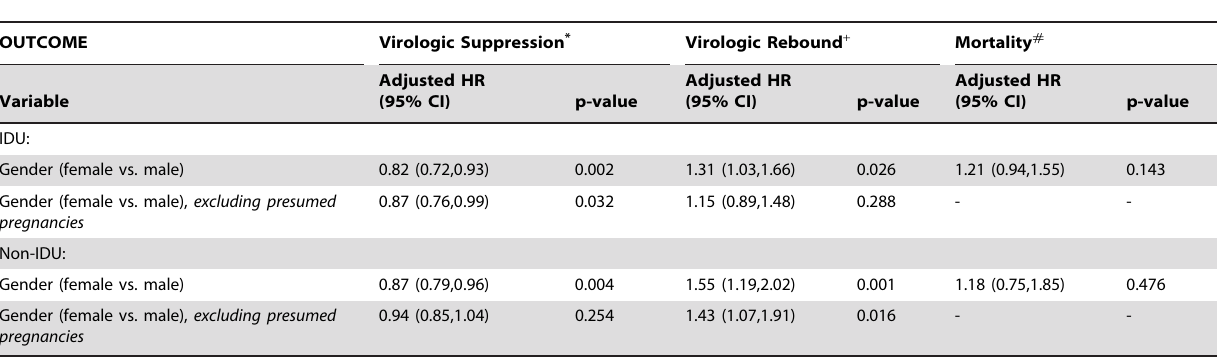
Table 3. Adjusted multivariable analyses exploring gender differences by IDU history in clinical outcomes, with and without ART use in pregnancy